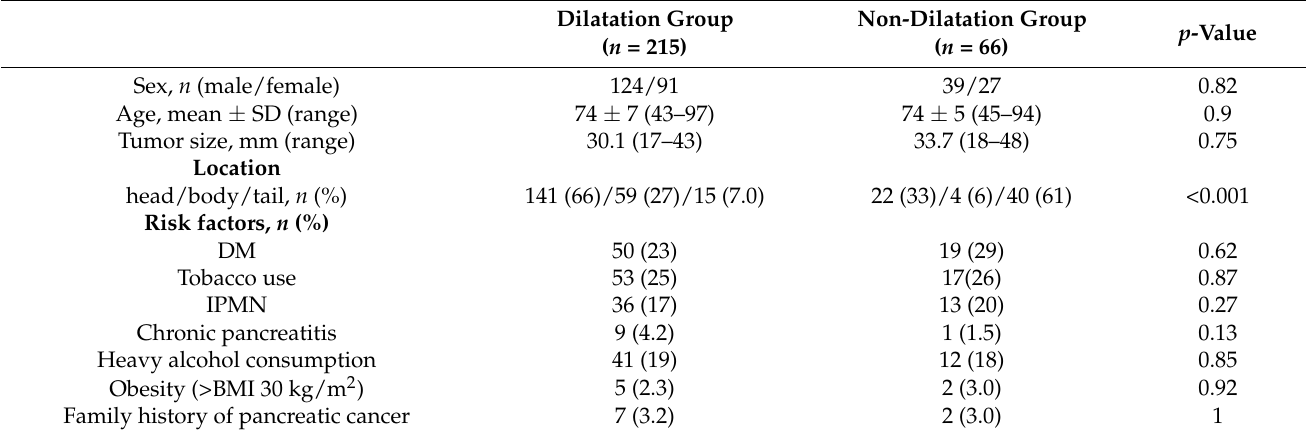
Table 1. Clinical